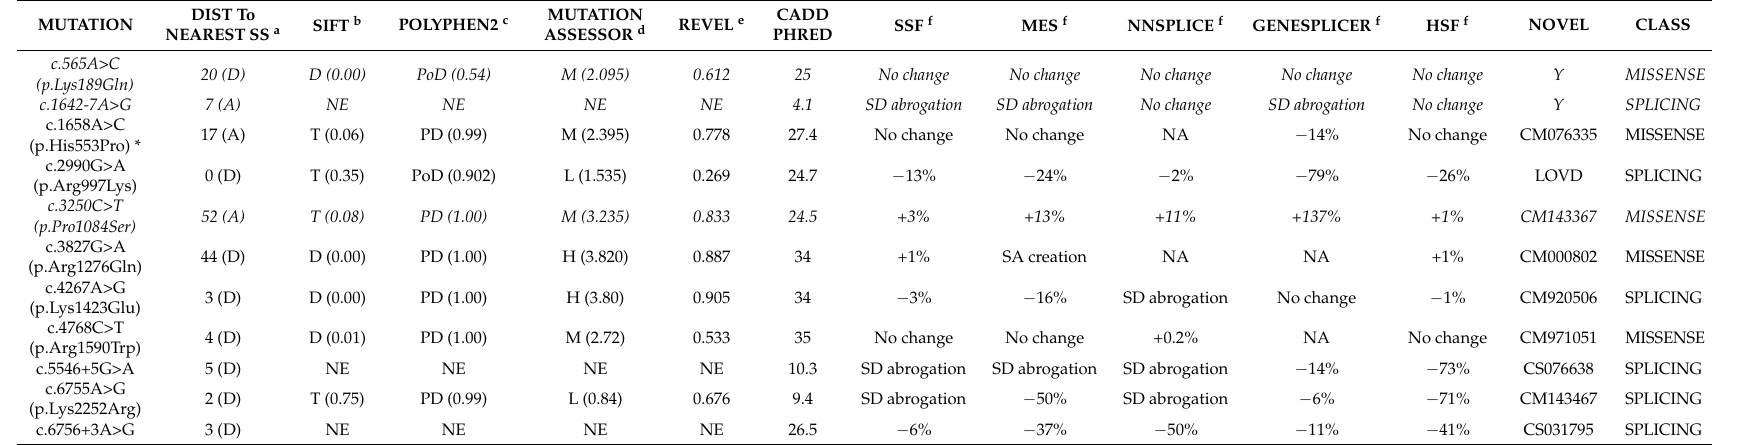
Table 2. In silico analysis of putative missense and splicing